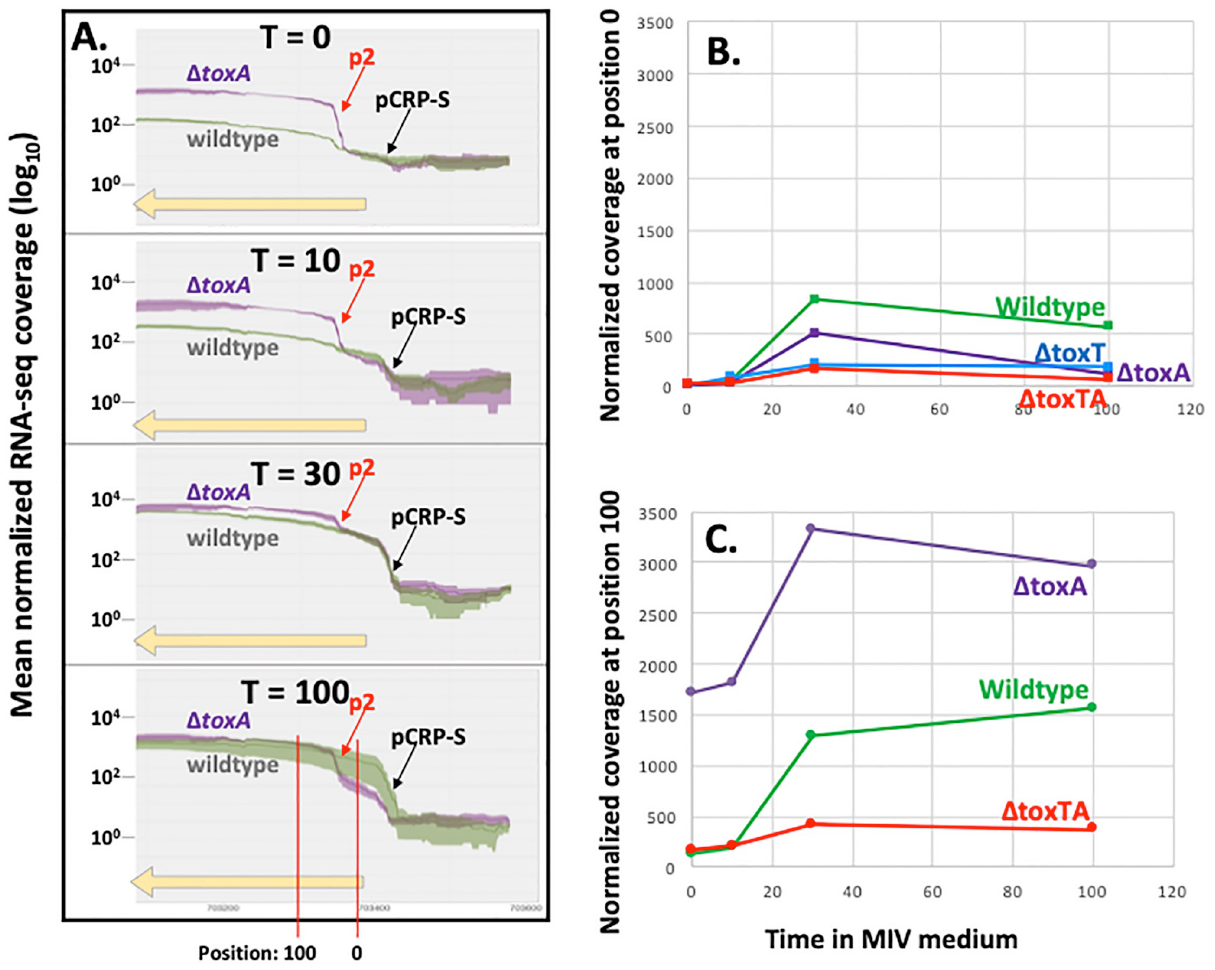
Fig 8. Sequencing read coverage of the H . influenzae toxTA promoter region. A . The green (KW20) and purple ( Δ toxA ) lines indicate mean coverage normalized by library size using DESeq2 [size factors] at each position; shaded areas indicate standard errors. The yellow horizontal arrow indicates the 5’ half of toxT (note that in this figure transcription is from right to left). B . and C . Time course of normalized read coverage at two specific positions in the toxTA operon. B . Position 0 = toxA start codon. C . Position